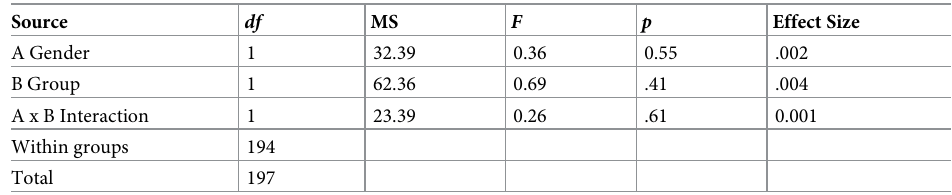
Note .—MS = Mean squares, effect size = partial η 2 .